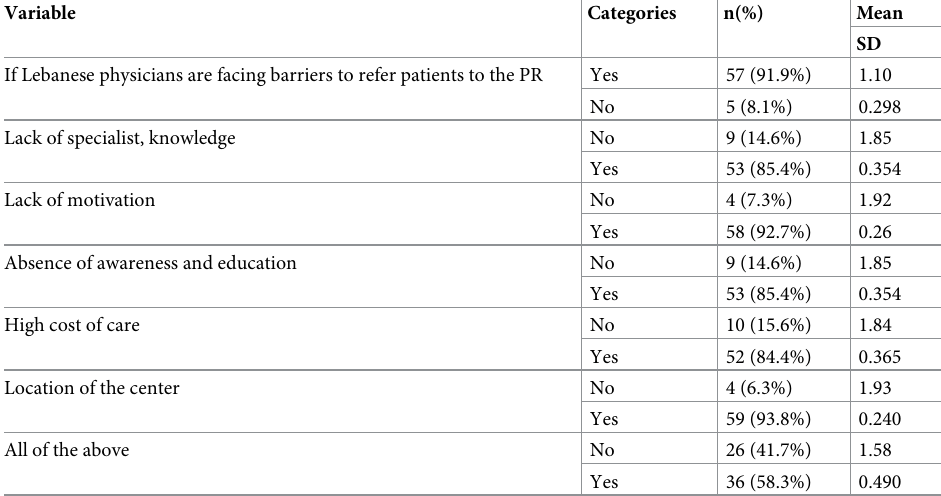
Table 5. Kind of barriers facing by respondents to pulmonary rehabilitation (PR), N = 62.